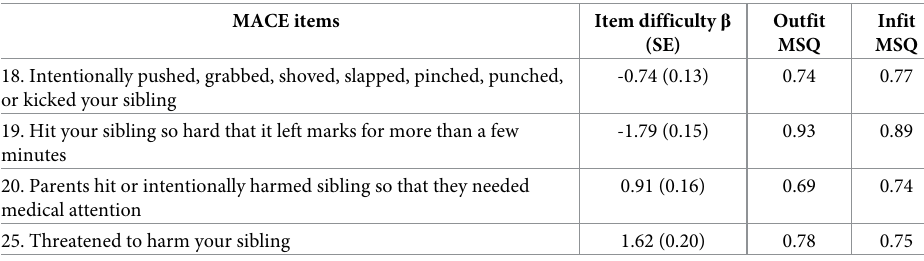
Table 7. Rasch analysis of witnessing violence to siblings subscale. MACE